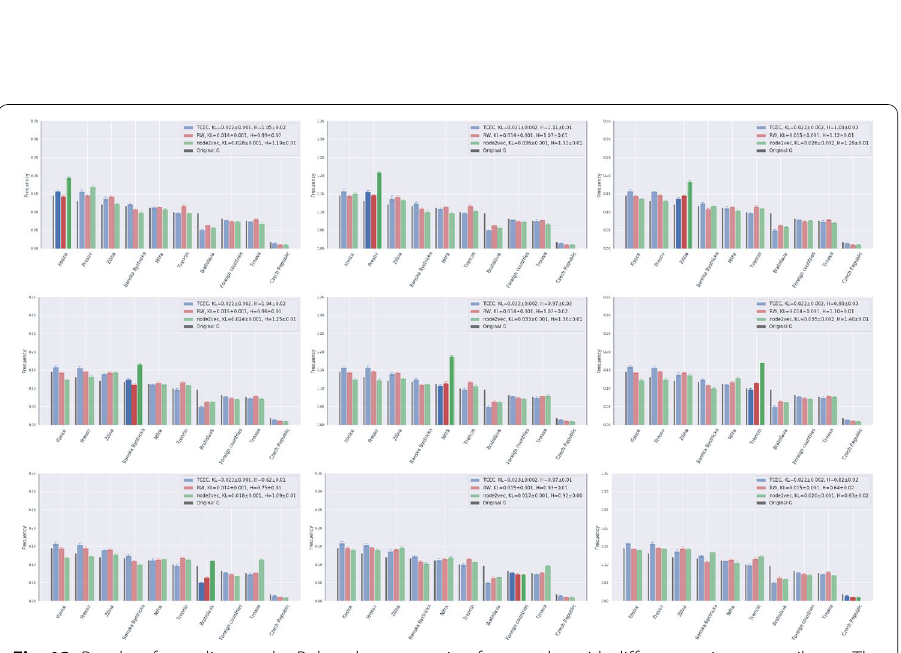
Fig. 13 Results of sampling on the Pokec dataset starting from nodes with different regions as attributes. The distribution on the whole network is the black vertical line. Vertical lines on top of bars represent standard deviations across 10 runs of sampling. Numbers inside the legend are KL-divergence and entropy ratios between attribute distribution on the entire network and that inside the sample, as defined in the main